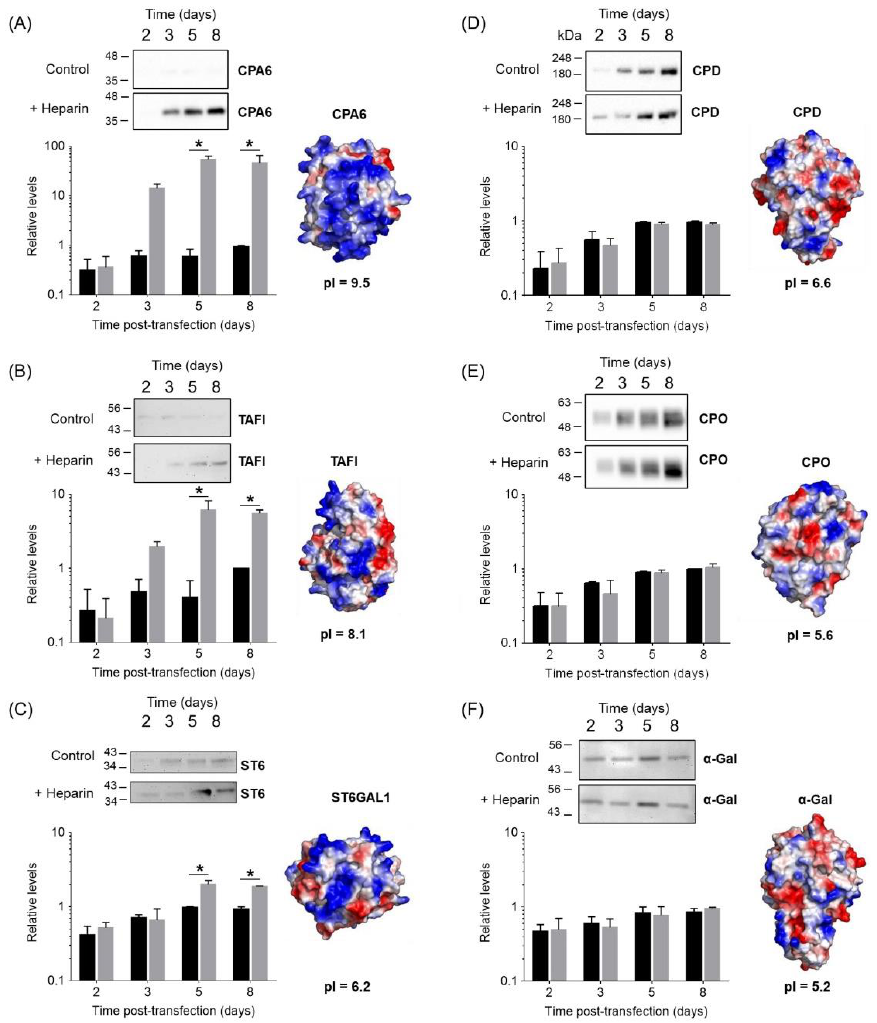
Figure 3. Comparative expression profiles of a set of biomedically relevant enzymes upon heparin supplementation. Immunoblots and relative expression levels were determined for three different heparin-binding proteins: ( A ) CPA6, ( B ) TAFI and ( C ) ST6GAL1. The expression was evaluated in the absence (black bars) or in the presence (grey bars) of 50 IU/mL of sodium heparin added 72 h after transfection, as described in the experimental section. The expression profiles of ( D ) CPD, ( E ) CPO and ( F ) α - galactosidase (α -gal) were analyzed as control proteins. In all cases, the values were normalized to the maximum protein signal detected in the conditioned medium in absence of heparin. Values are mean ± SEM of 3 independent experiments. In all cases, structural models showing the electrostatic surface potential distribution are presented. The coordinates used are: CPA6 (AlphaFold model AF-Q8N4T0-F1), TAFI (PDB code 3LMS), ST6GAL1 (PDB code 4JS1), CPD domain II (AlphaFold model AF-O75976-F1), CPO (PDB code 5MRV) and α -gal (6IBR). All the structural representations were generated with Pymol [36]. Two-way ANOVA was performed, followed by Sidak’s multiple comparison test, which was limited to comparing the mean protein levels in the presence and absence of heparin for the different time points. The two-way ANOVA suggested that CPA6, TAFI and ST6GAL1 expression levels depended both on the presence/absence of heparin and the days of expression. For CPD and CPO, the two-way ANOVA indicates that only the time of expression significantly influences the levels of expression of these proteins. Meanwhile, α -gal expression levels are independent of the presence/absence of heparin and the expression time. The asterisk represents a significant difference in means between absence and presence of heparin when an α of 0.05 is considered.